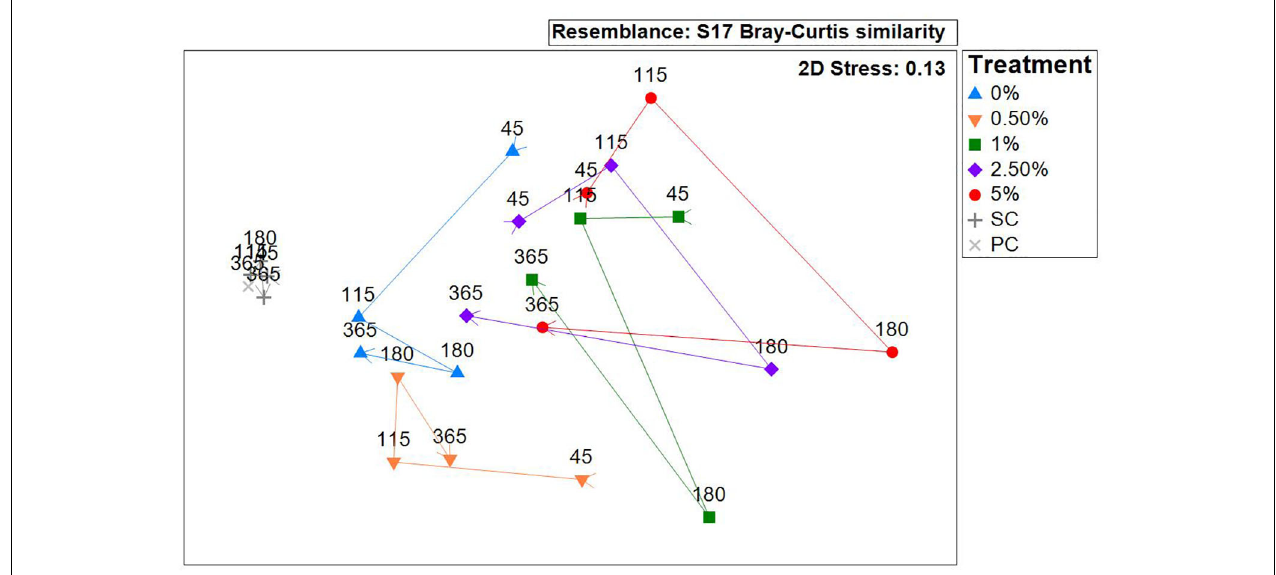
FIGURE 8 | Non-parametric multi-dimensional scaling (nMDS) ordination (based on Bray–Curtis similarity matrix on untransformed abundance data, replicates averaged for each treatment at each time point) showing temporal changes over the 365 days study period. Colored lines link each treatment and the arrows at the start and end of each line show the temporal change in macrofaunal community structure from 45 to 365 days, and how similar the communities in the different tailings treatments are relative to the communities in the background mudflat sediments (points situated closer together indicate greater similarities in community